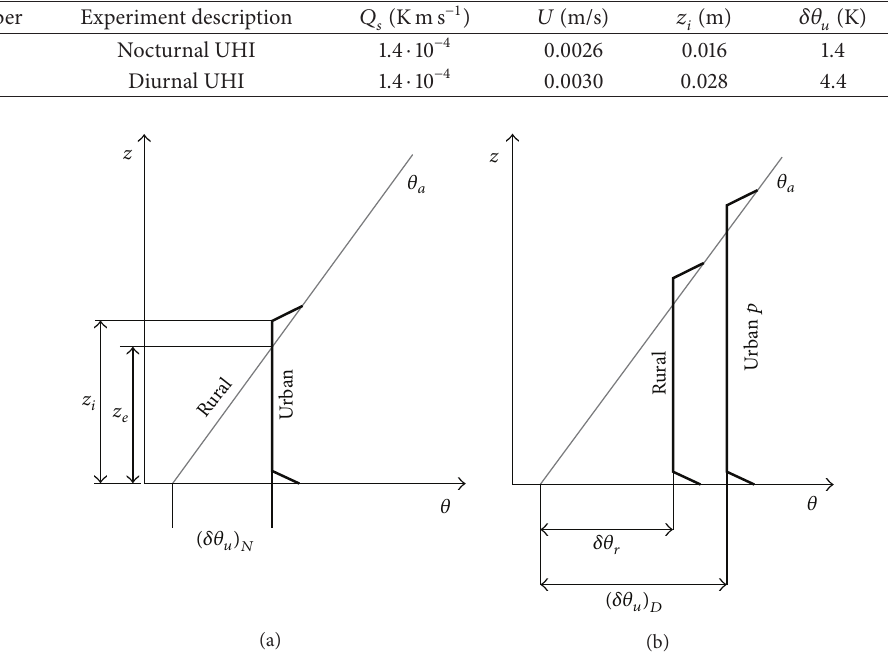
Figure 28: Schematic diagram defining (a) nocturnal and (b) diurnal urban heat island intensity.